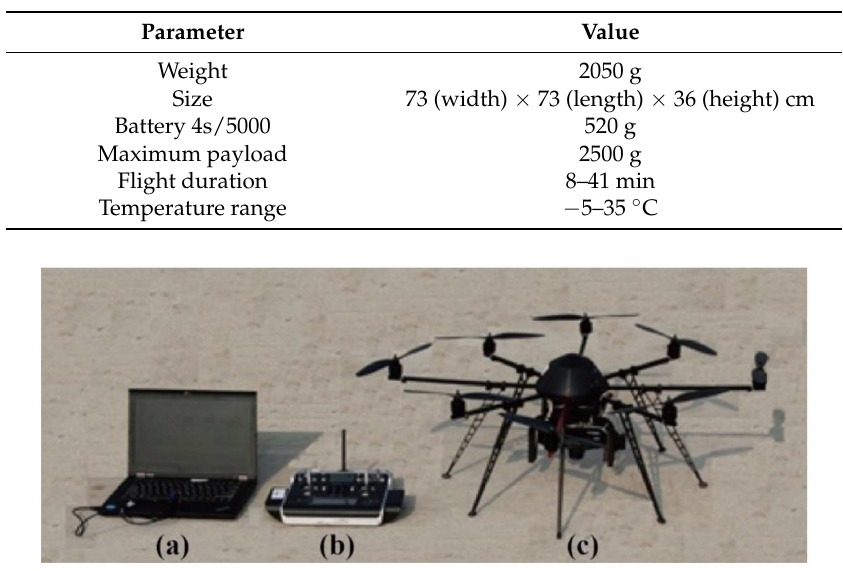
Table 2. The specifications of the parameters for the ARF-MikroKopter unmanned aerial vehicle (UAV).